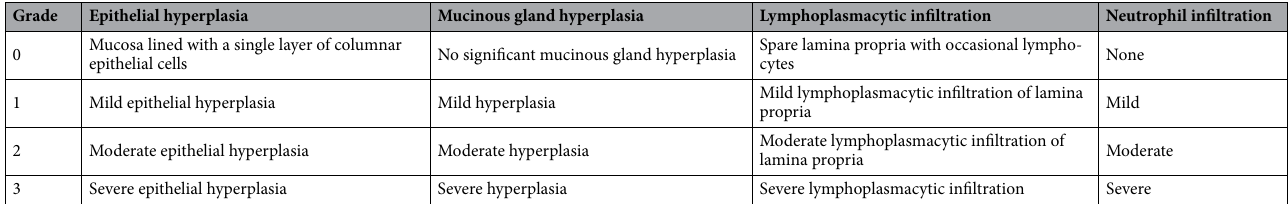
Table 1. Grading system for the common bile duct tissue damage.